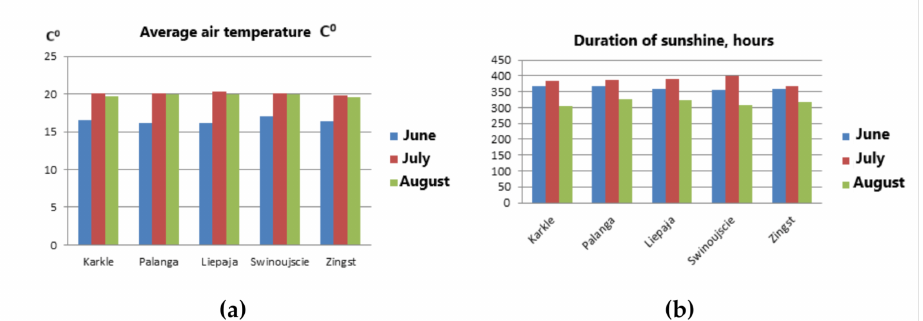
Figure 3. Climate parameters at South Baltic seaside and marine resorts in the summer months from 2010 to 2018 (our compilation): ( a ) Average monthly air temperature ( ◦ C); ( b ) Duration of sunshine